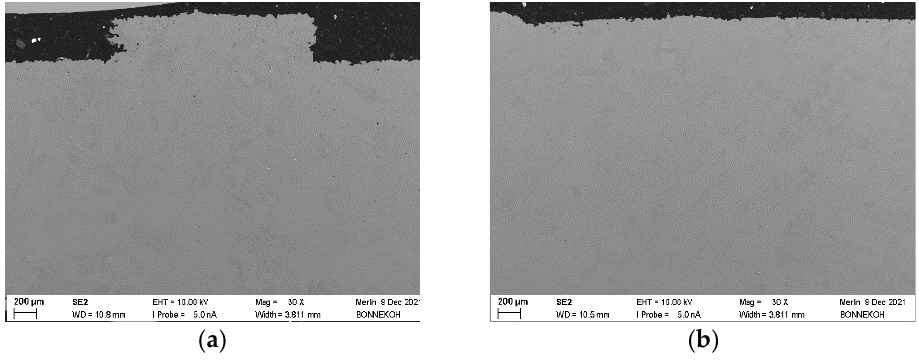
Figure 19. SEM fracture images of sintered parts PEG(8000)60/PMMA40 feedstock (solid load: 60 vol%, 5 wt% PAT-77P). ( a ) Intersection plane; ( b ) sintered (FFF); ( c ) sintered (PIM).